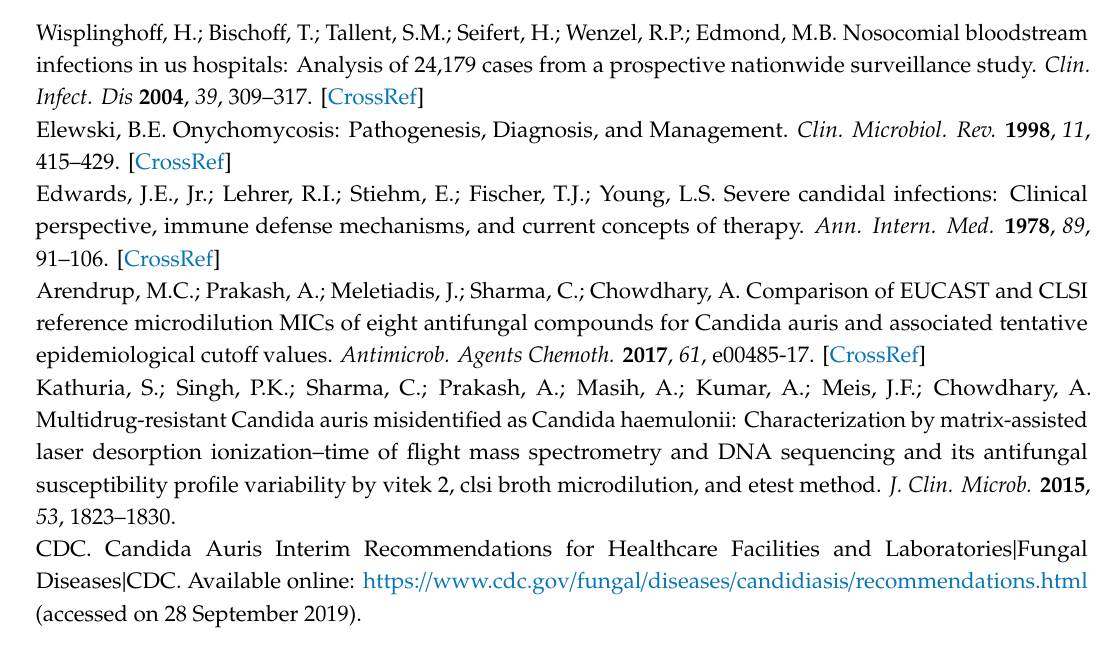
Supplementary Materials: The following are available online. Supplementary Figure S1 and spectroscopy date of compound UoST5 including mass, 1 H-NMR and 13 C-NMR